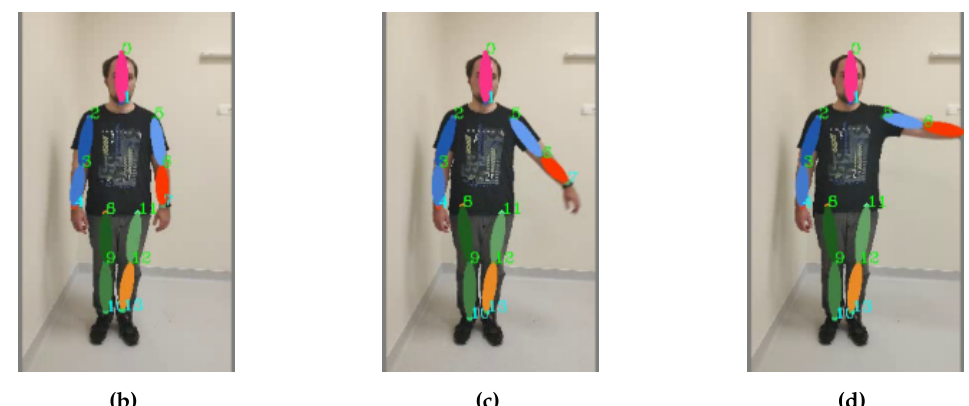
Figure 10. Footage of the Finger–Nose exercise: the motion sequence ( a – d ) starts on the left and ends on the